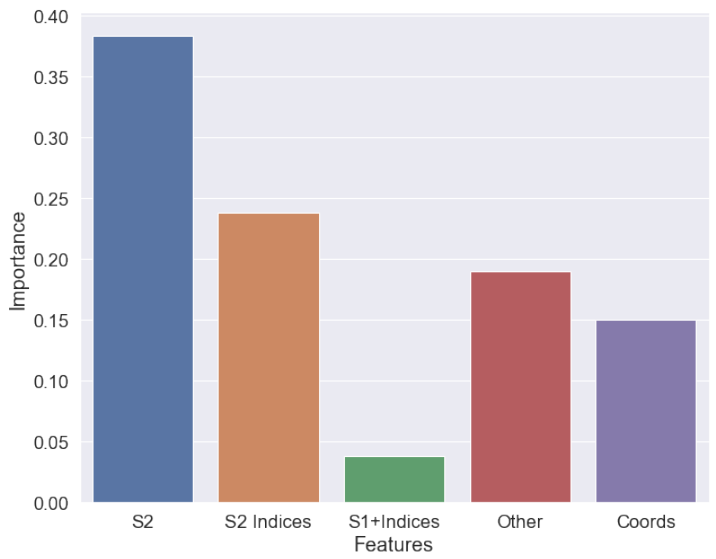
Figure 11. Importance of characteristics grouped by typology.